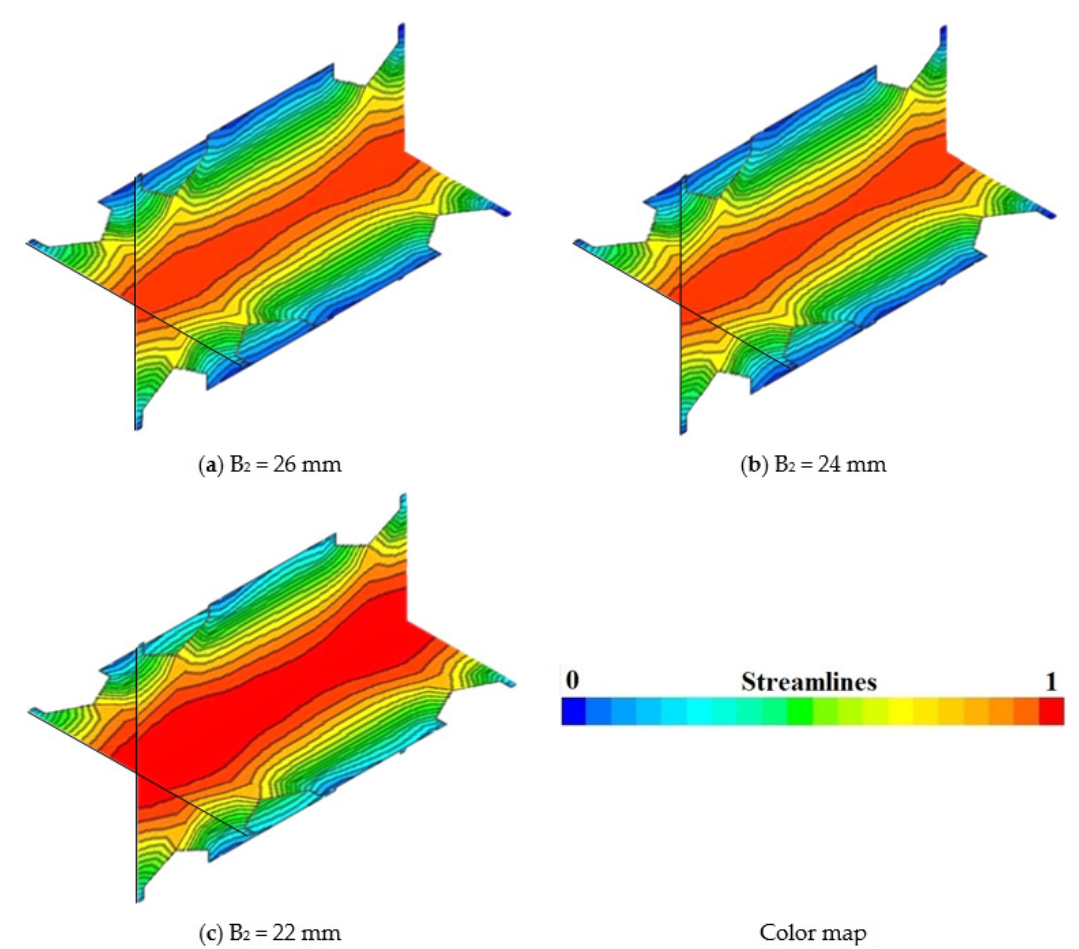
Figure 16. Streamlines for various configurations of Case B with different B 2 parameters at R = 15 mm, Re = 15,000, and ϕ = 0.5%.